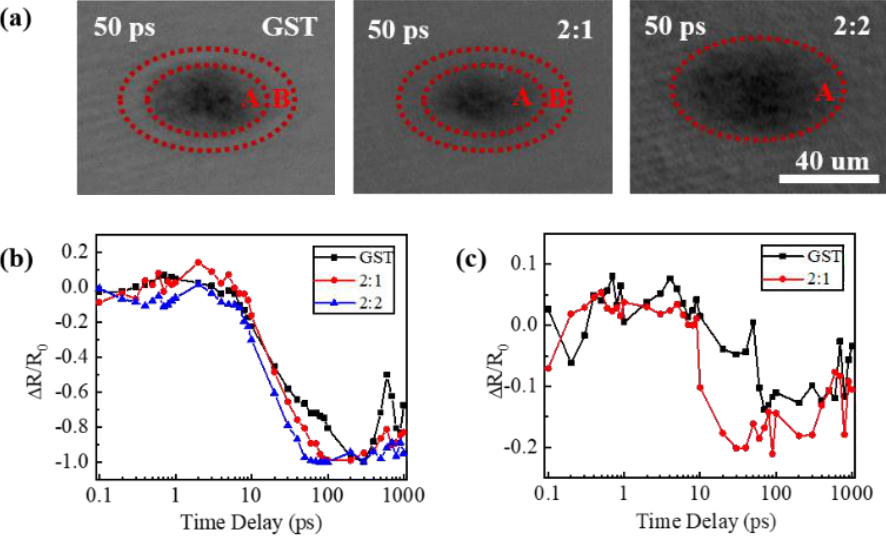
Figure 4. ( a ) Zones A and B in spatial-resolved images of three kinds of films at a time delay of 50 ps after exposure to the pump pulse; ( b ) Reflectivity dynamics of Zone A for the pure GST, 2:1 and 2:2 films; ( c ) Reflectivity dynamics of Zone B for the pure GST and 2:1